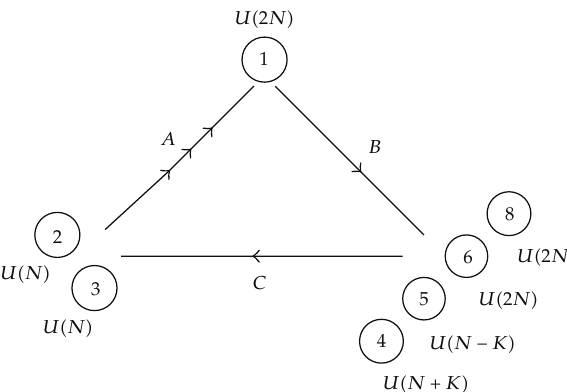
Figure 3: Quiver gauge theory for the cone over dP 6 after adding the fractional branes.